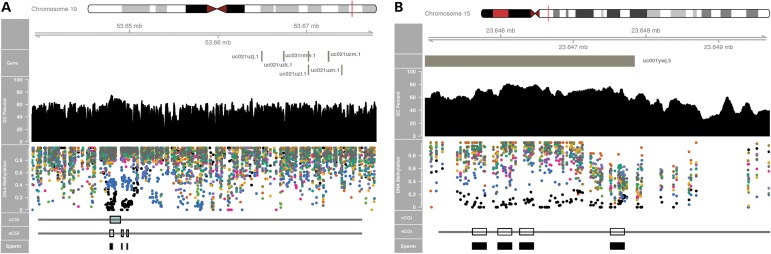
(A) Imprinted CGI in the upstream of C19MC miRNA cluster is annotated as eCGIs. (B) Cluster of four novel eCGIs in the imprinted gene MAGEL2. The color scheme for DNA methylation values (dots) is identical to that in Figure 3.